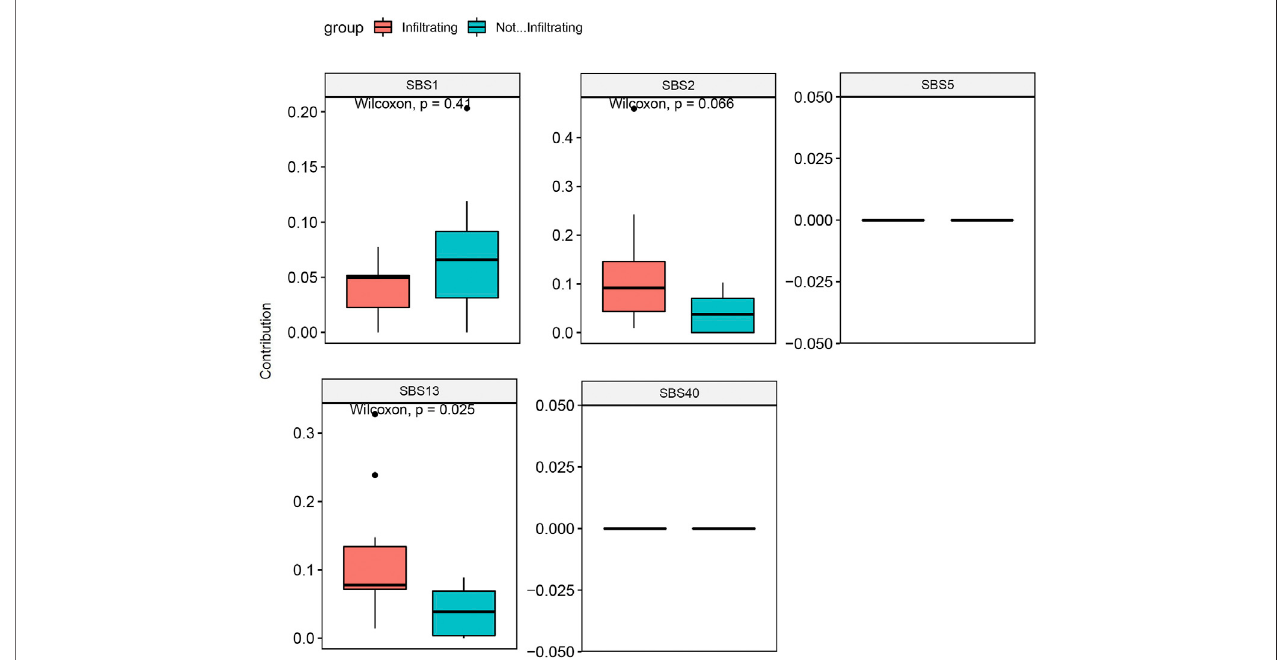
FIGURE5 | Mutation signature contribution analysis ofNMIBC and MIBC samplesbased on SBSs 1, 2,5, 13, and 40 forbladder cancer. Data wereexpressed as median (interquartile range) and were statistically analyzed by Mann-Whitney U test. NMIBC: non-muscle invasive bladder cancer; MIBC: muscle-invasive bladder cancer; SBS: single-base